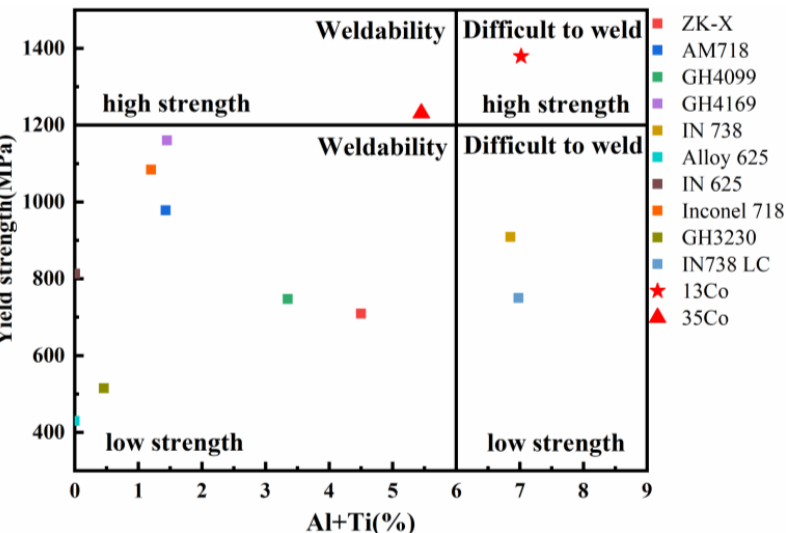
Figure 12. Comparison of the yield strength versus (Al + Ti)% for Ni-based superalloys in our work and other studies; all Ni-based superalloys were prepared via selective laser melting except for two superalloys, ZK-X and GH3230, which were prepared via laser melting deposition. Except for 13Co and 35Co alloys, the rest of the alloys are from the Refs. [39 – 48].